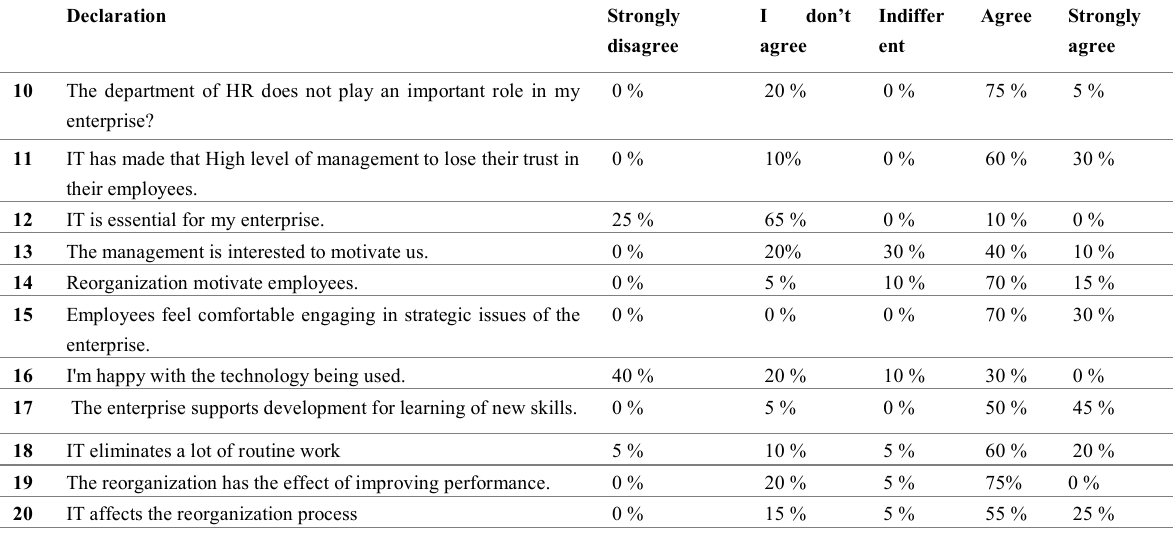
Table 4: Technology, reorganization in employee